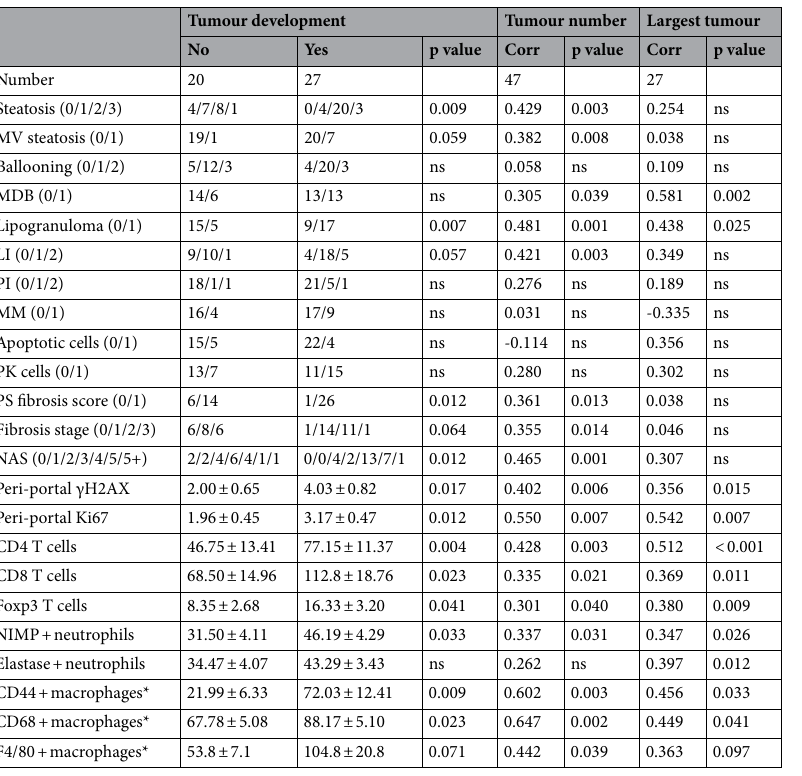
Table 2. Histological features associated with tumours. Differences between continuous non-parametric were assessed with Mann–Whitney Tests. Differences between categorical datasets were assessed with Chi Square Exact tests. Immune cell counts are shown for 15 high power fields (HPF) for T cells and neutrophils, with the mean of 10 HPF shown for macrophages. Macrophage data are on a subset of 23 cases. Key: MV— microvesicular; MDB—Mallory Denk bodies; LI—lobular inflammation; PI—portal inflammation; MM— megamitochnodria; PK—pigmented Kupffer cells; PS—peri-sinusoidal. Follow-up study at 48 weeks, n = 47; *subset of cases used for RNA-Seq (n =